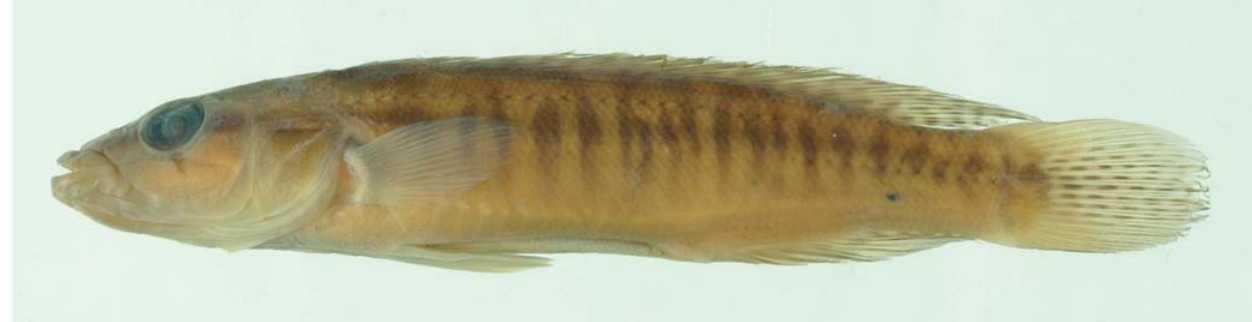
Fig. 1. Crenicichla mucuryna , USNM 307807, 84.0 mm SL, rio Mucuri, Nanuque, State of Minas Gerais,